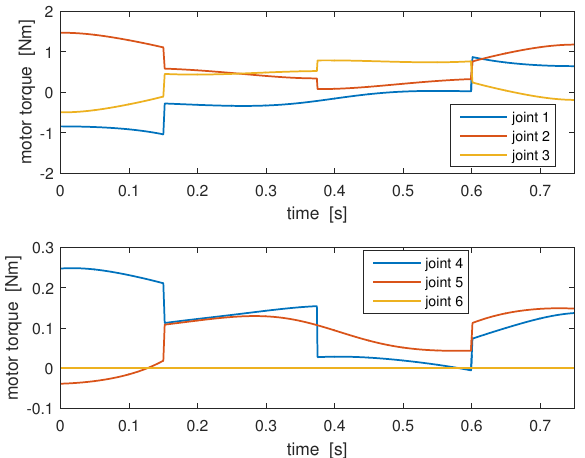
Figure 3. Motor torque for nominal tool orientation with the non-optimized profile: ϕ = 0 rad , θ = 0 rad , ψ = 3 π /2 rad